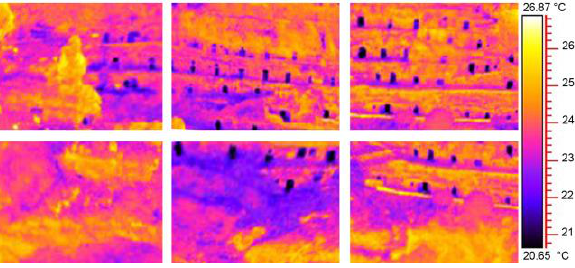
Figure 1. Thermal image of the ravine of an area of the Casalnuovo District